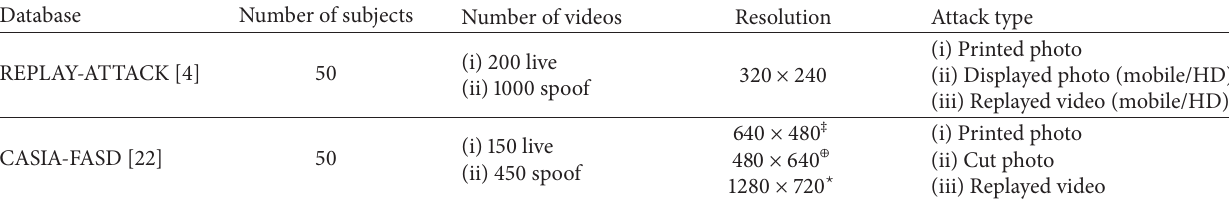
Table 2: Summary of two databases used in this